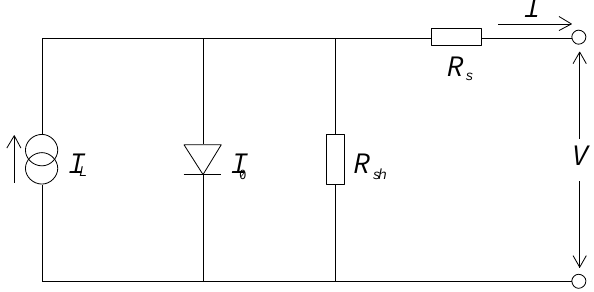
Figure 3. One-diode equivalent circuit for a PV panel.